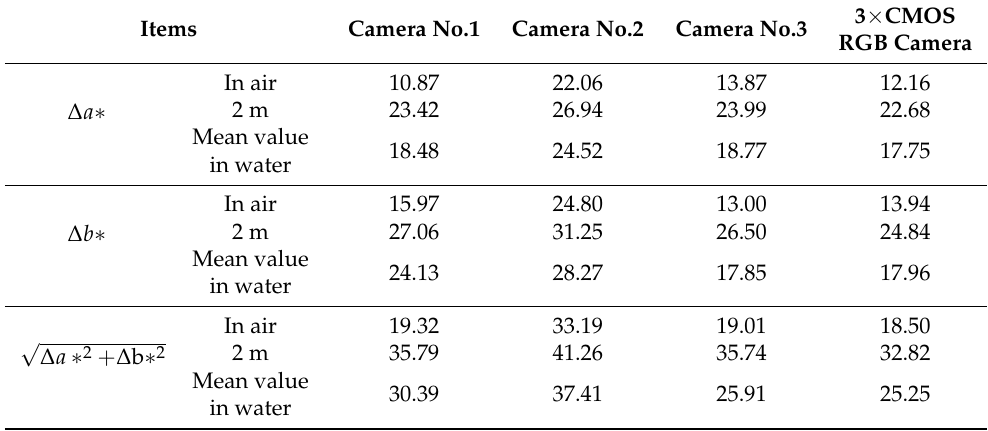
Table 2. The Color deviation with different